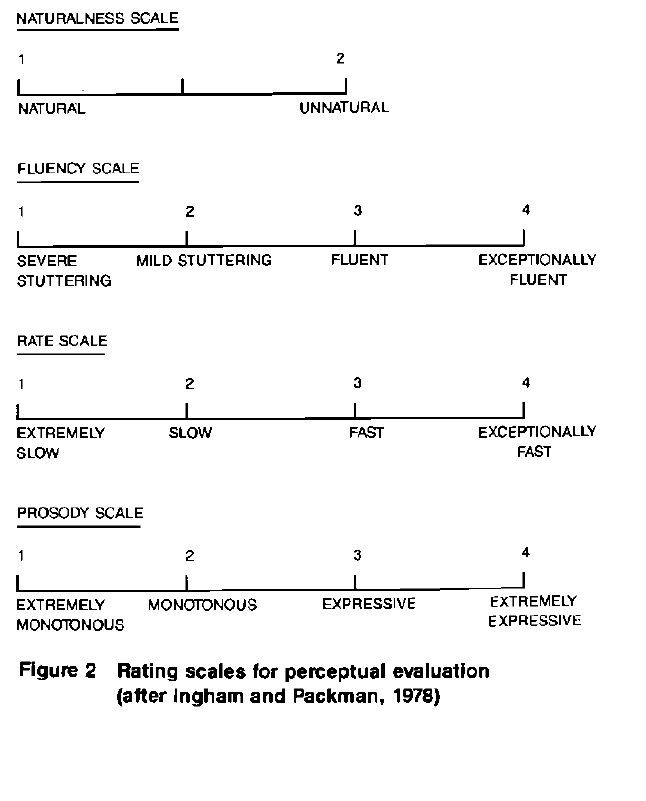
Figure 2 Rating scales for perceptual evaluation (after Ingham and Packman,